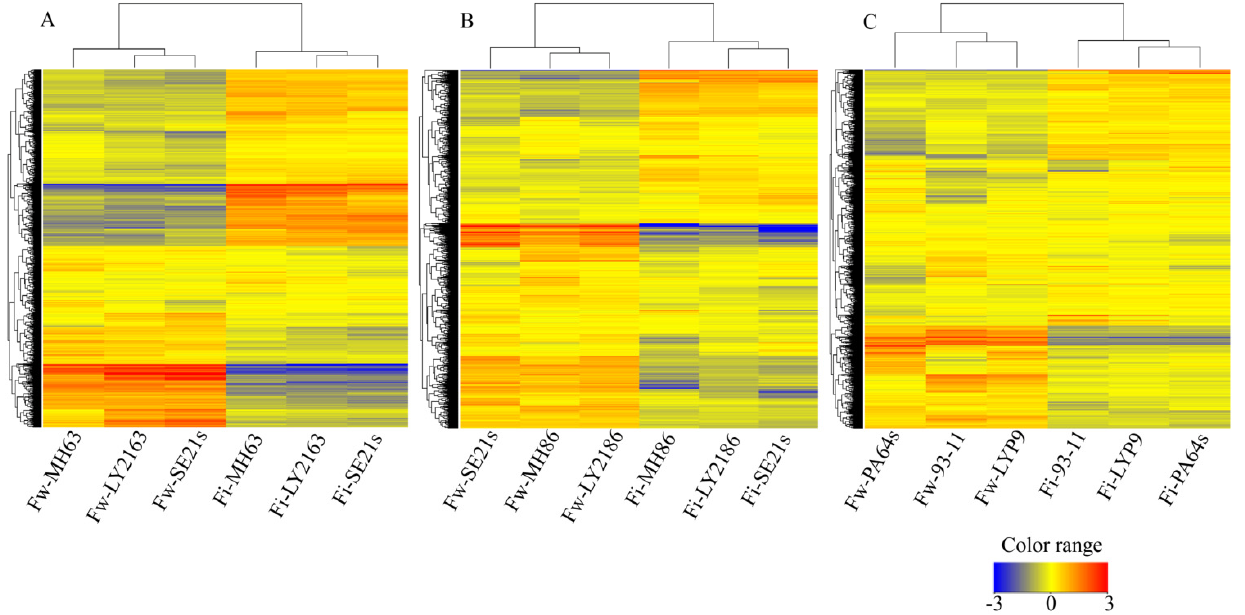
Figure 1. Clustering analysis of expressed genes among three hybrid combinations. Hierarchical clustering was done by GeneSpring 12.6 using normalized data. ( A ) LY2163 hybrid combination; ( B ) LY2186 hybrid combination; ( C ) LYP9 hybrid combination. Fw, flowering; Fi,